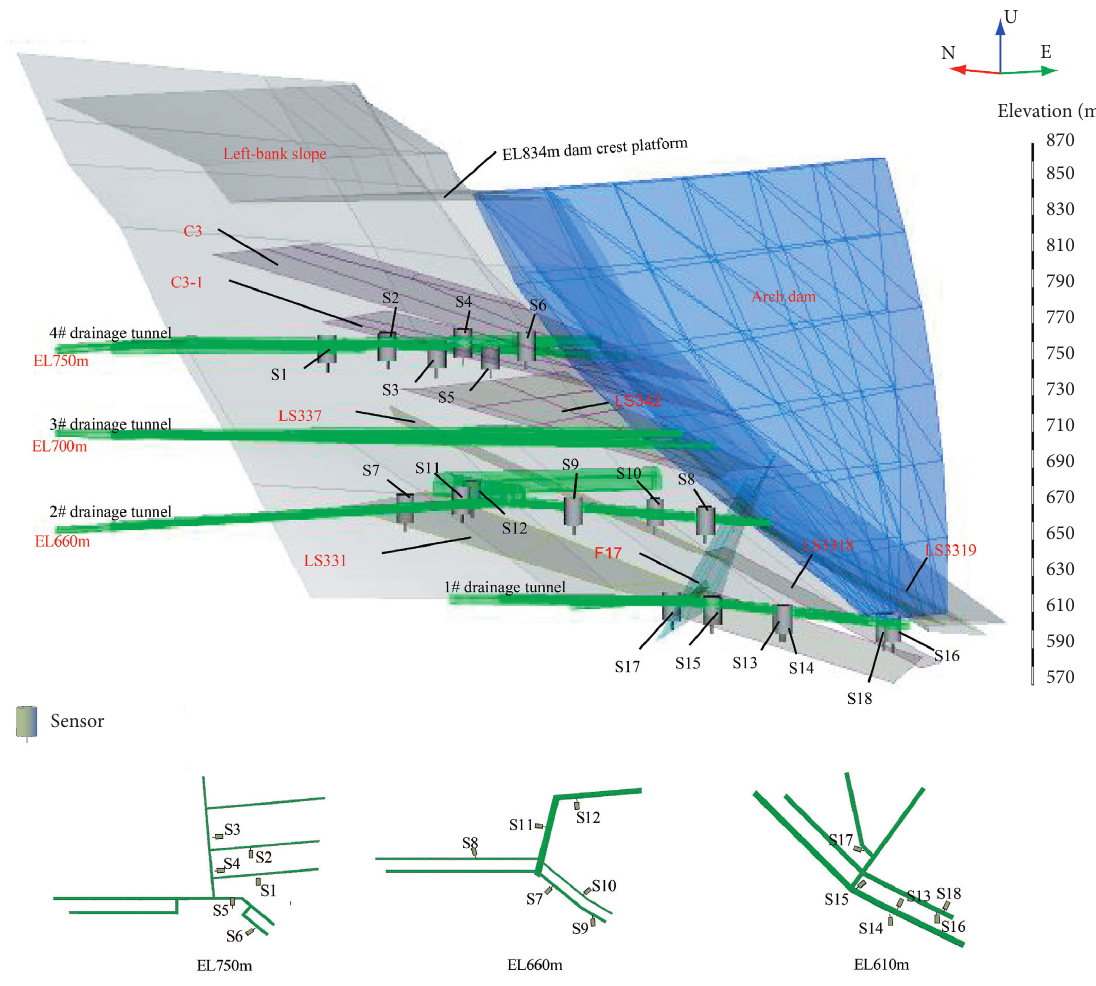
Figure 5: Spatial arrangement diagram of the sensor in the left bank